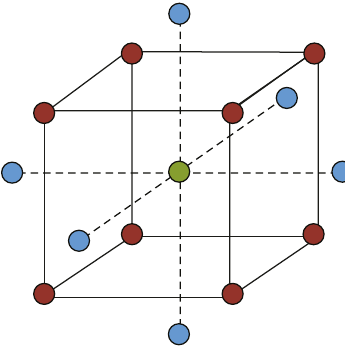
Figure 6: Central composite design (CCD) for experimental designs in three